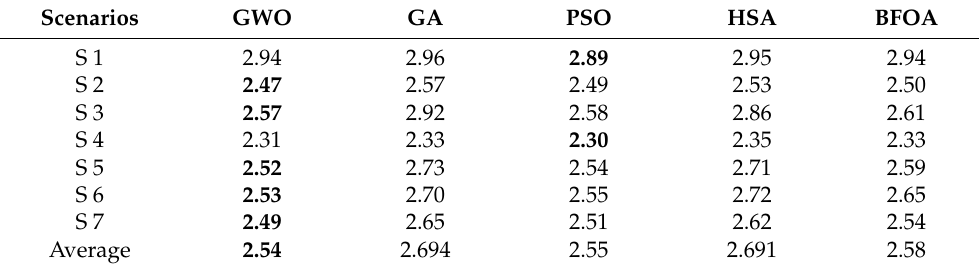
Table 14. Comparison between the five algorithms in terms of PAR reduction. Scenarios